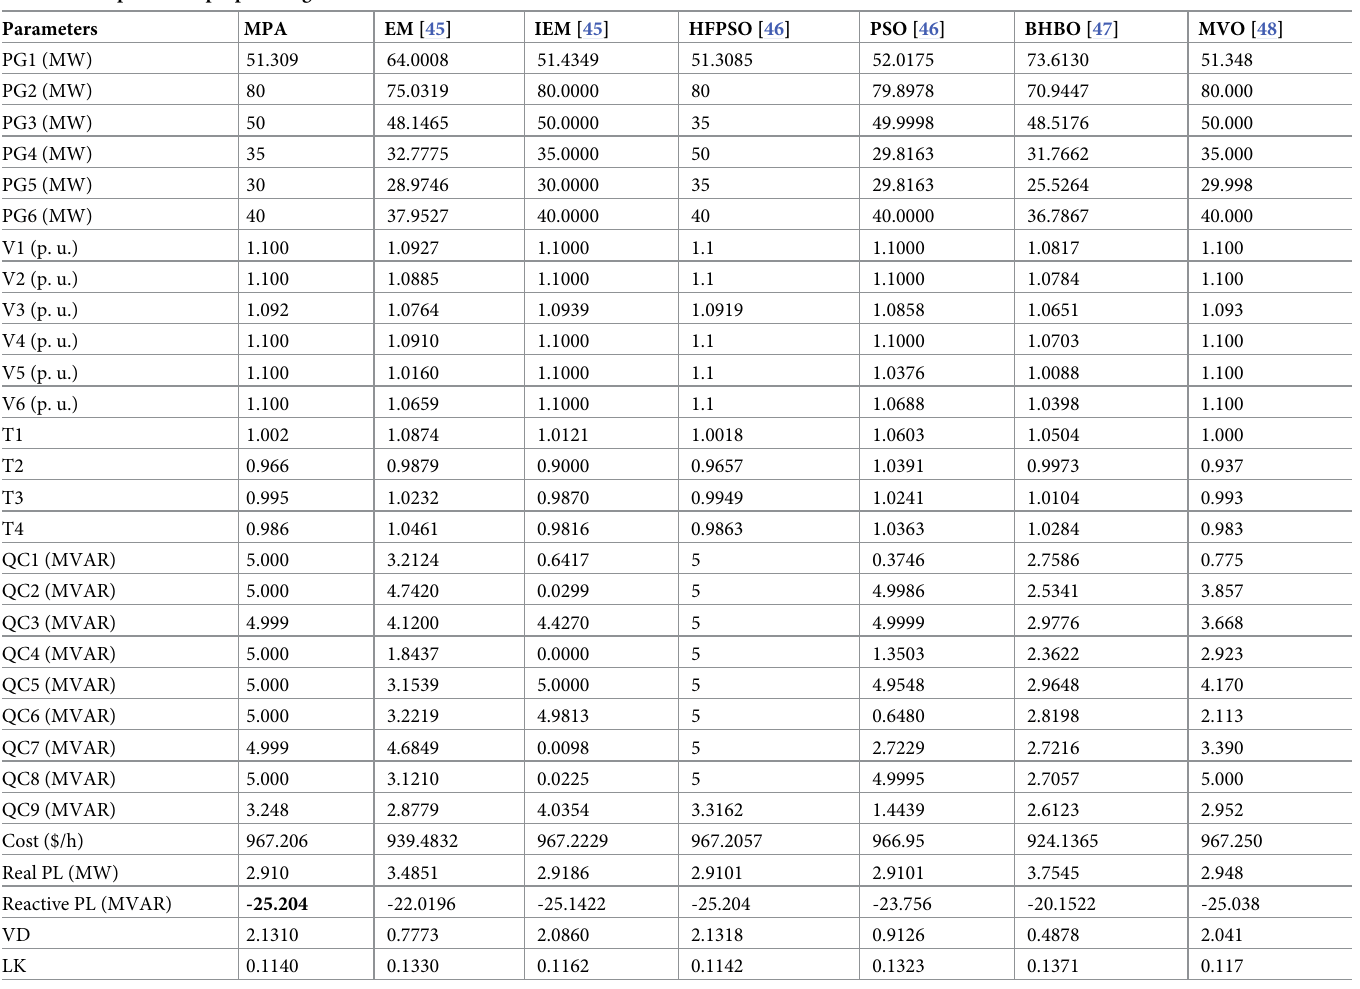
Table 4. Comparison of proposed algorithm with other literature work for case 3. Parameters